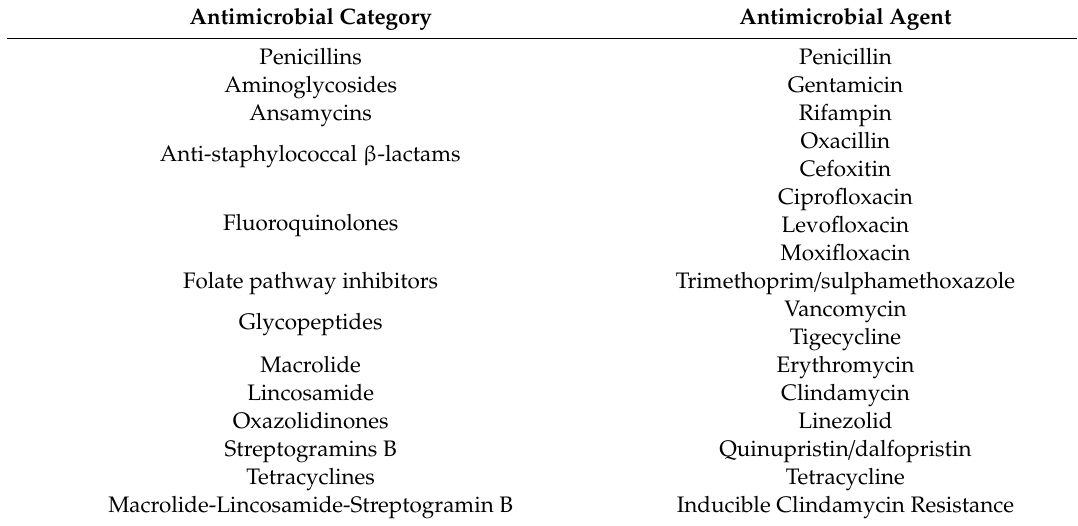
Table 1. Antimicrobial categories and agents used in this study.